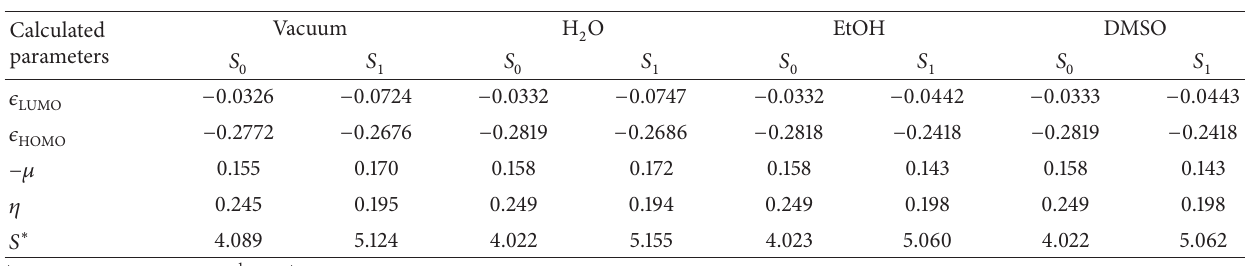
Table 1: Ground and excited states’ computed reactivity indices values in a.u. ∗ of (a) 5-FU, (b) uracil, (c) TU, and (d) DTU in different media.